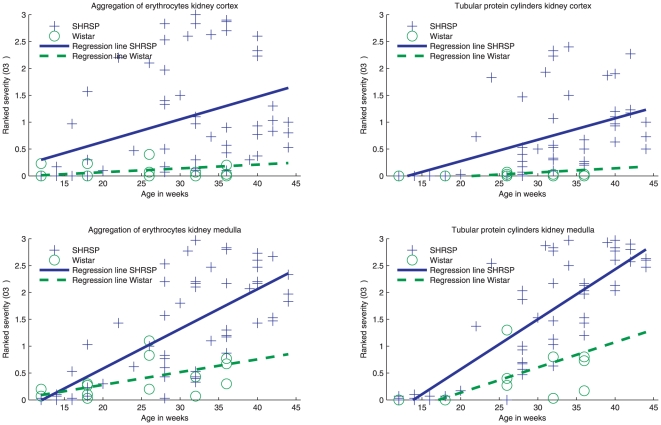
Association between the kidney pathology and age in SHRSP and Wistar rats.Regression lines. The regression lines in 
Figure 6
 demonstrate the positive association between the severity of the kidney pathology (y-axis) and the age (x-axis) in SHRSP (blue) and Wistar (green) group. The extent of peritubular aggregated erythrocytes and the extent of tubular protein cylinders is separately assessed in the kidney medulla and cortex and is captured in a semiquantitative manner (0–3, y-axis; see also 
Figure 1

and
Material and Methods, kidney). Note the increase of the severity of the kidney pathology with age in SHRSP (cortex: erythrocyte aggregations, regression coefficient [rc] 0.042, CI 0.019-0.065, p = 0.001; protein cylinders, rc 0.04, CI 0.025–0.055, p = <0.001; medulla: erythrocyte aggregations, rc 0.074, CI 0.057–0.090, p = <0.001; protein cylinders, rc 0.093, CI 0.079–0.107, p = <0.001) and to a lesser extent in the Wistar group (cortex: erythrocyte aggregations, rc 0.07, CI -0.001–0.015, p = 0.08; protein cylinders, rc 0.008, CI 0.005–0.011, p = <0.001; medulla: erythrocyte aggregations, rc 0.024, CI 0.014–0.034, p = <0.001; protein cylinders, rc 0.047, CI 0.033–0.061, p = <0.001) resulting in significant group differences (cortex: erythrocyte aggregations p = 0.045, protein cylinders p = 0.004; medulla: erythrocyte aggregations p = <0.001, protein cylinders p = <0.001).